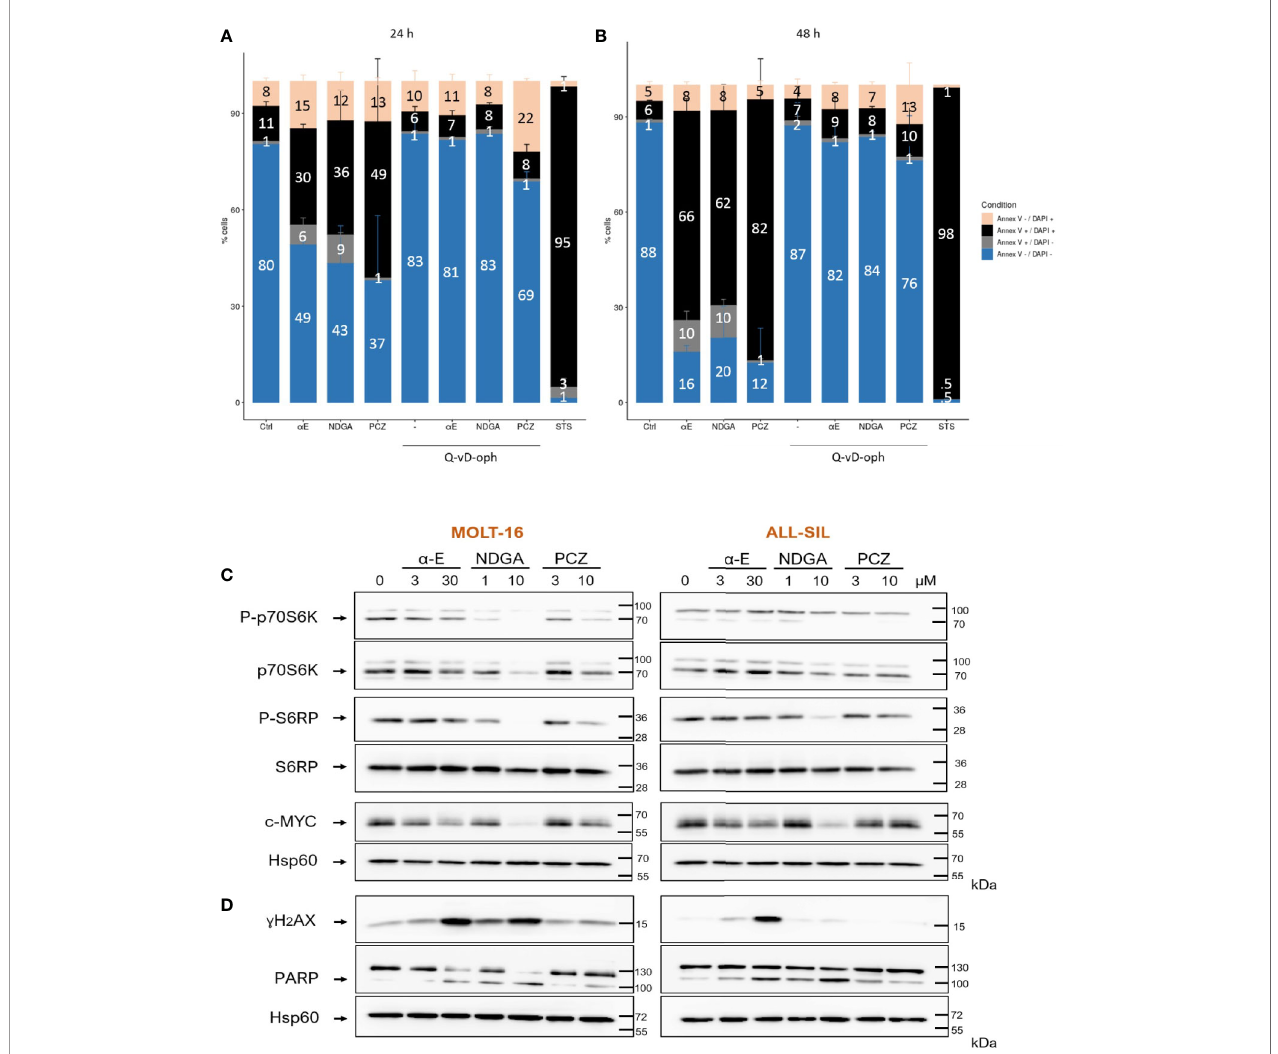
FIGURE 6 | a -Estradiol, Nordihydroguaiaretic acid, and Prochlorperazine induce cell death and affect cellular signaling in T-cell Acute Lymphoblastic Leukemia (T-ALL) cell lines. (A, B) Apoptosis was measured by fl ow cytometry following annexin V-FITC/DAPI staining after 24 h (A) and 48 h (B) of incubation with or without 20 µM of the pan-caspase inhibitor Q-VD-OPh. (C) Western blot analysis of the effects of a -E, nordihydroguaiaretic (NDGA) and prochlorperazine dimaleate (PCZ) on mTORC1 activation and cMyc protein levels, 18 h after incubation with drugs. mTORC1 activation was measured through the analysis of p70S6K and S6RP phosphorylation. (D) DNA damage was assessed through the appearance of g H2AX, while apoptosis was evaluated through the cleavage of PARP. Arrows point to the speci fi c bands of interest. Numbers on the right represent the molecular weight of SDS-PAGE markers in kilo Daltons (kDa). Protein band on Western blot were quanti fi ed using the ImageJ software. The signal of a given total protein was normalized to the signal of Hsp60, used as a loading control from the same sample. Bands corresponding to phosphorylated proteins were normalized to the signal of the corresponding total protein which had been normalized to Hsp60. The results are displayed on Supplementary Figure 4